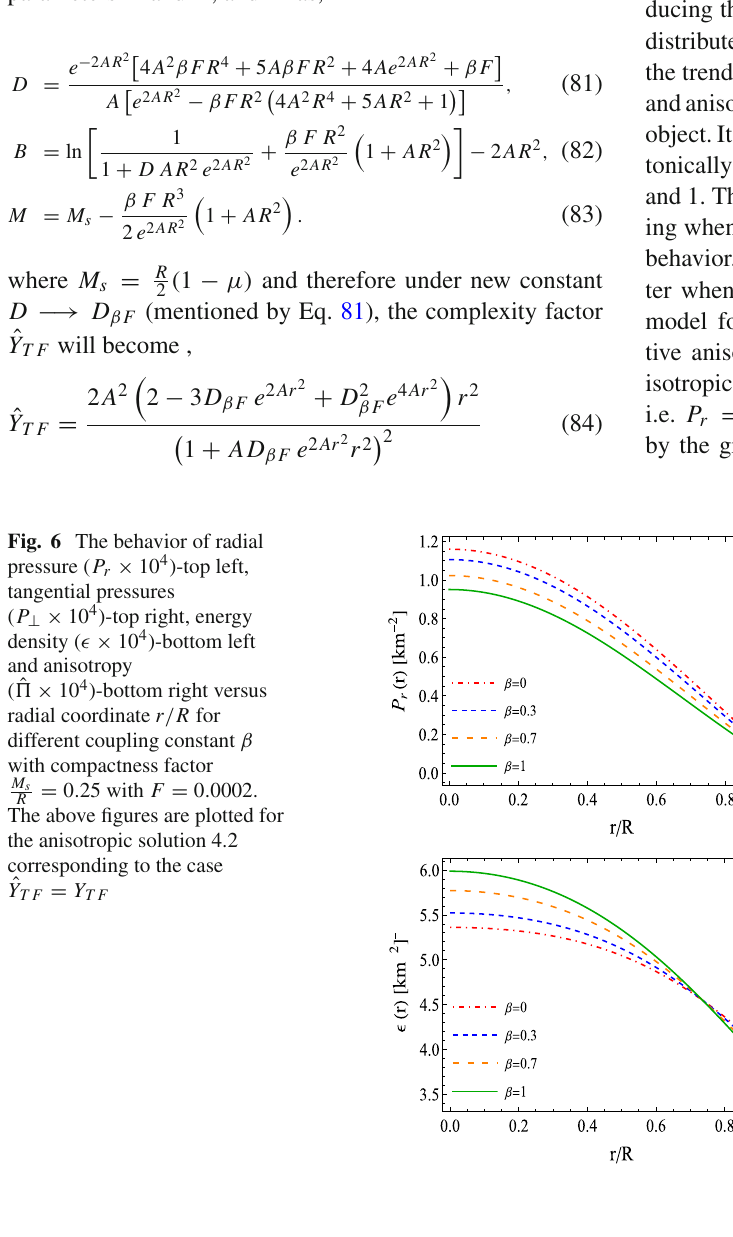
tion (74)–(80) determines the modified form of the constant parameters D and B , and M as,